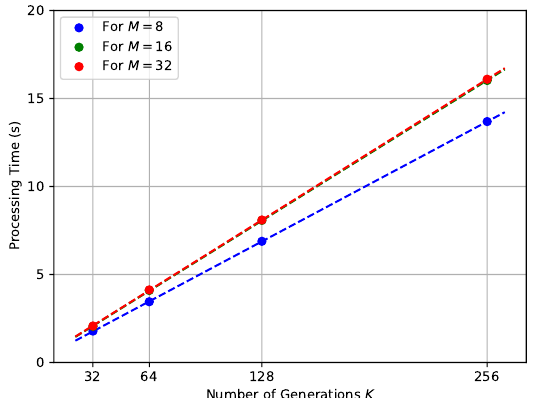
Figure 13. Best polynomial function that fits processing time for different values of number of generations, K .